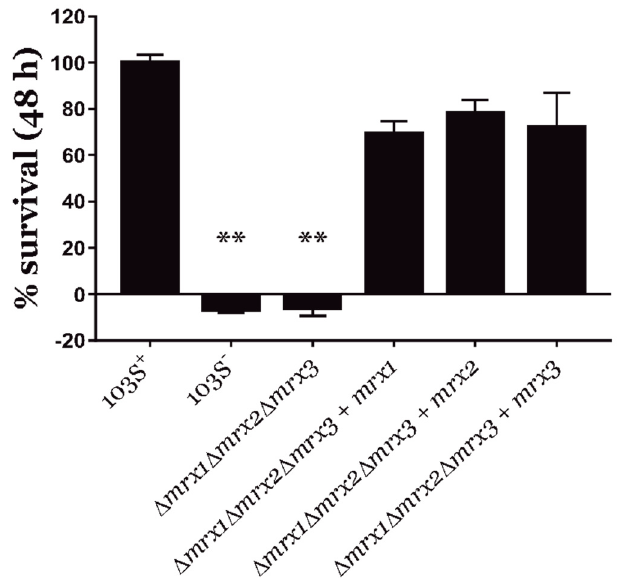
Figure 1. Macrophage infection assays. Intracellular survival in J774.A macrophages of the wild type R. equi 103S + strain, the virulence plasmid cured R. equi 103S − strain, the triple ∆ mrx1 ∆ mrx2 ∆ mrx3 mutant, and R. equi ∆ mrx1 ∆ mrx2 ∆ mrx3 strain individually complemented with each mrx gene. Bacterial viability was measured by quantifying the number of colony-forming units (CFUs) of each strain at 48 h, and data were normalized by the percentage of R. equi 103S + CFUs. Data are expressed as means ± SD of three independent experiments. One-way ANOVA and post hoc Tukey´s multiple comparison tests were performed to assess for statistical significance related to the wild type strain. ** p -value < 0.01.